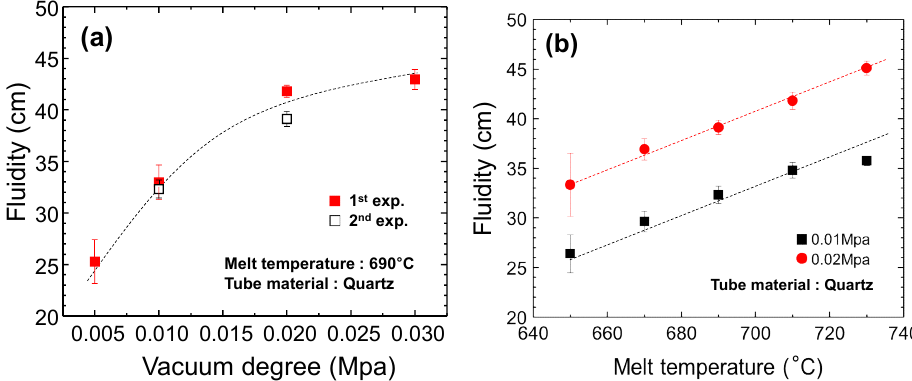
Figure 5. The effect of ( a ) vacuum degree and ( b ) both vacuum degree and melt temperature on the fluidity of the A356 alloy.